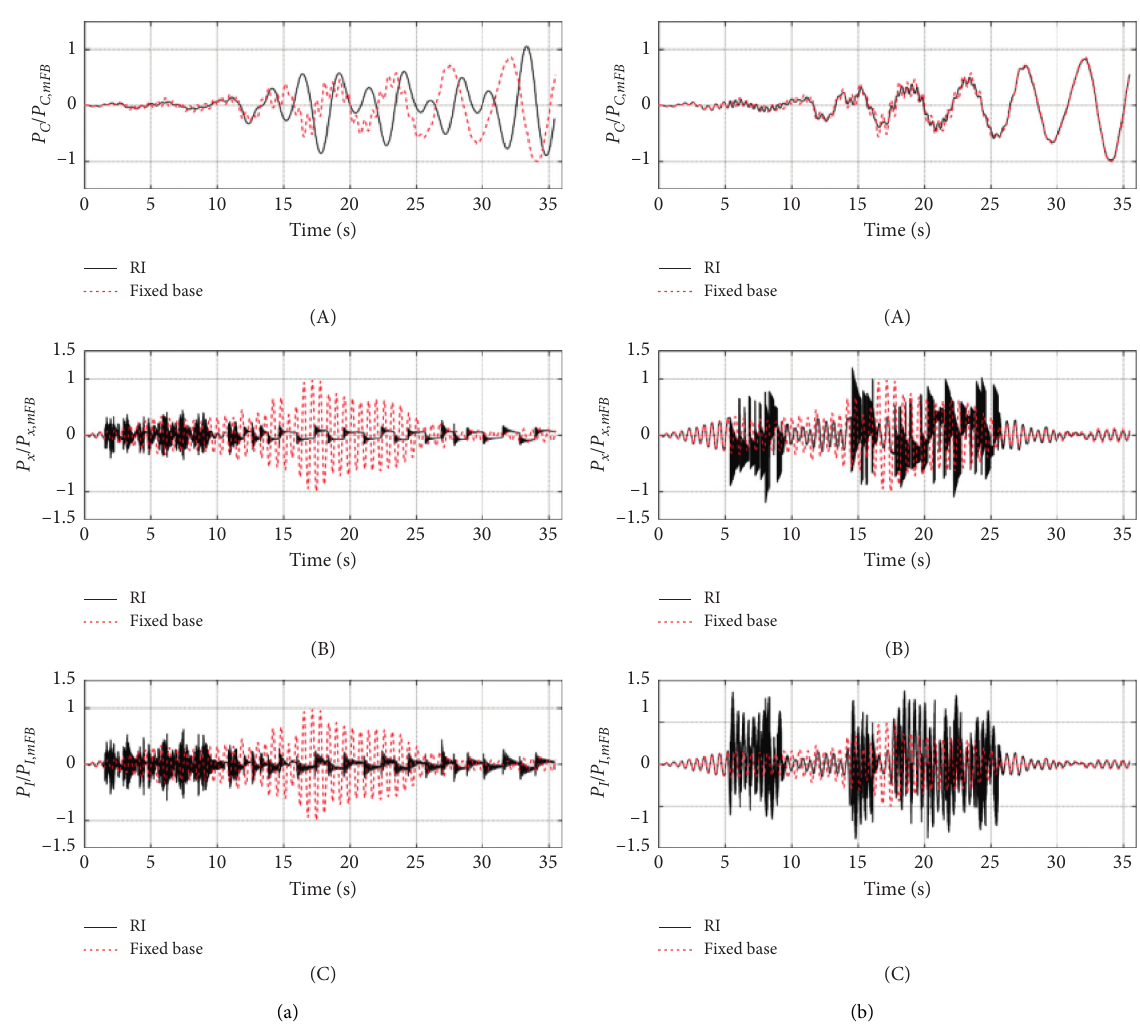
Figure 14: Normalized time histories of the distributed hydrodynamic forces induced by (A) convective, (B) flexibility, and (C) impulsive components for the structure with C1 (a) and C2 (b).